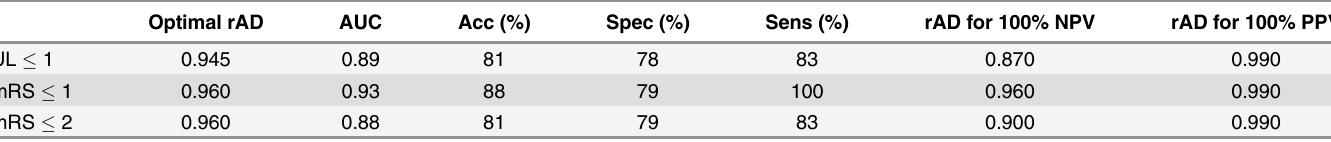
Table 4. Receiver-Operator Curve (ROC) models for